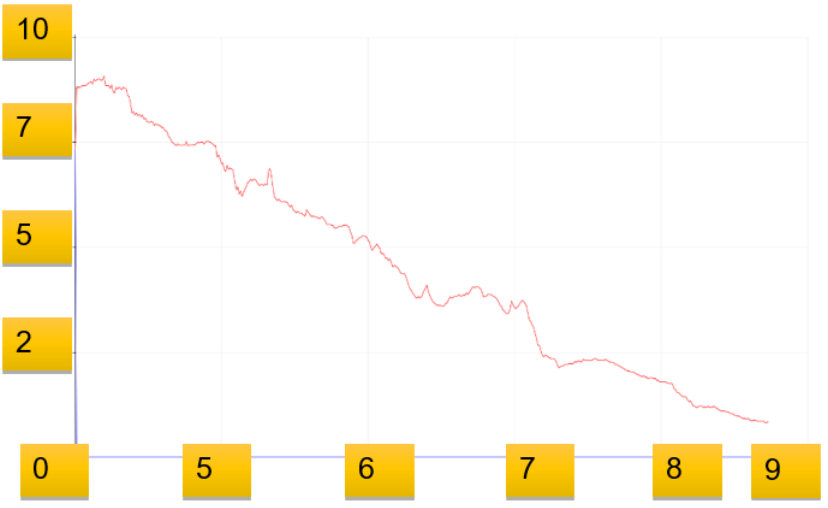
Figure 10. Flame Sensor in the presence of